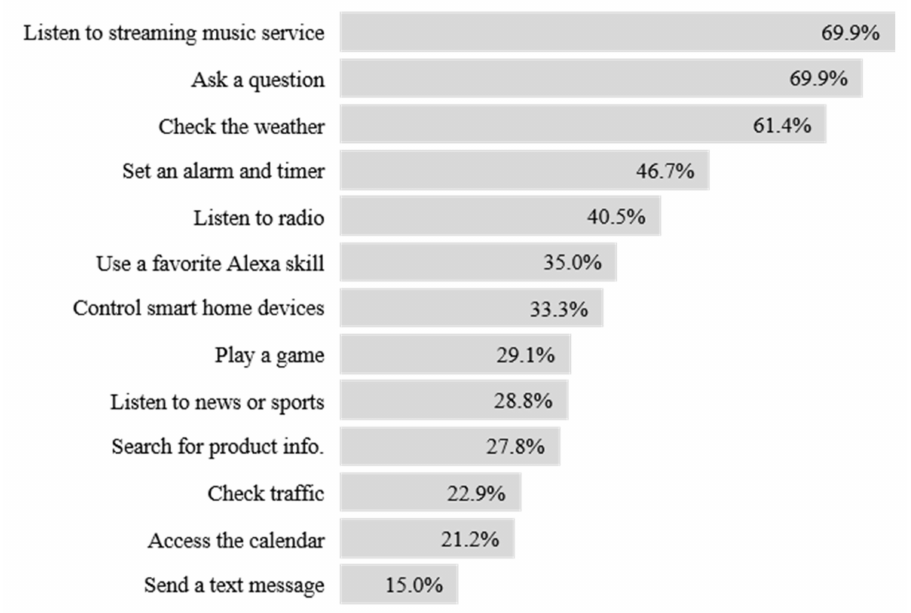
Figure 2. AI speaker use case